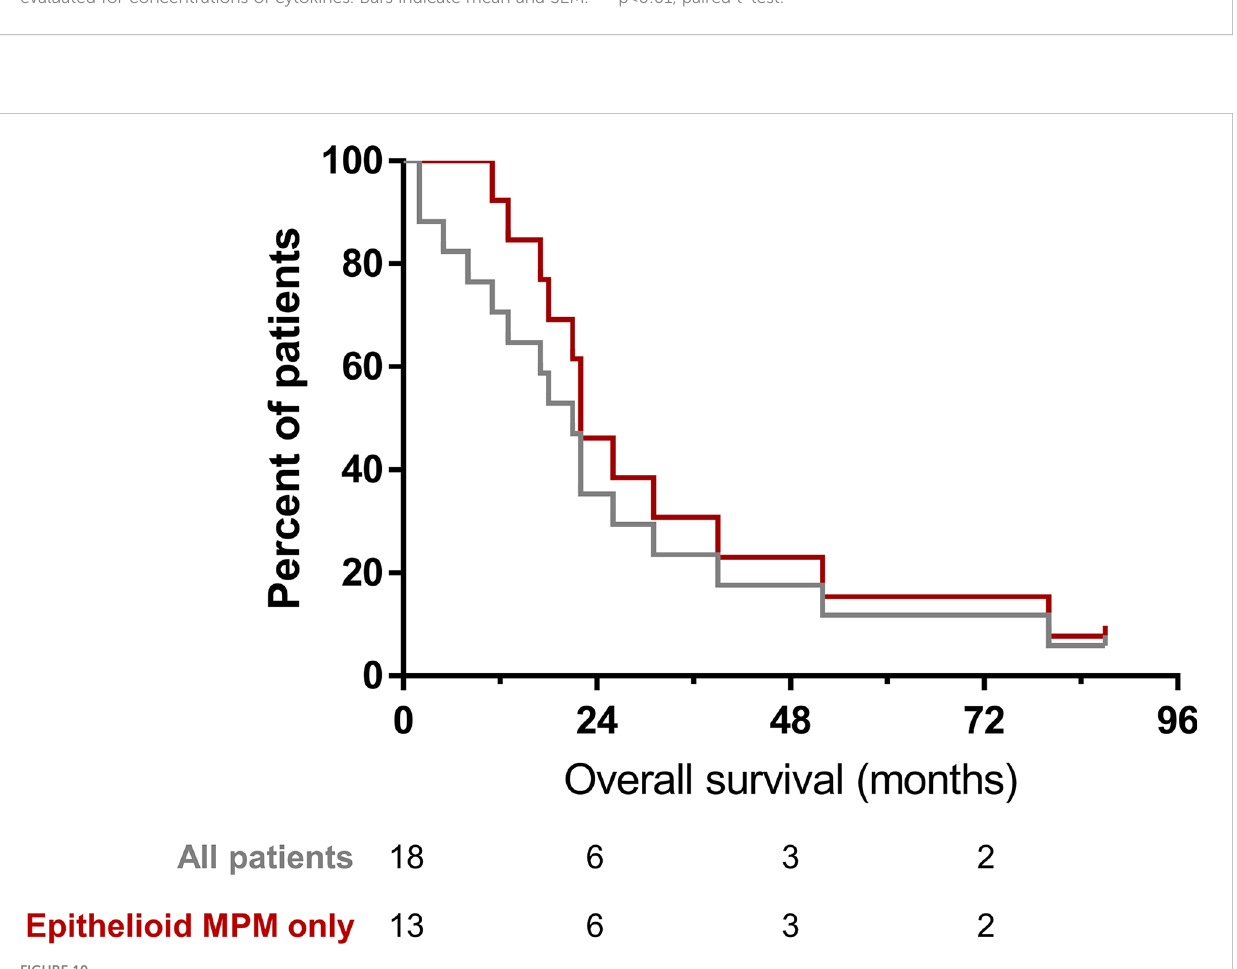
FIGURE 10 Overall survival of patients following Olvi-vec